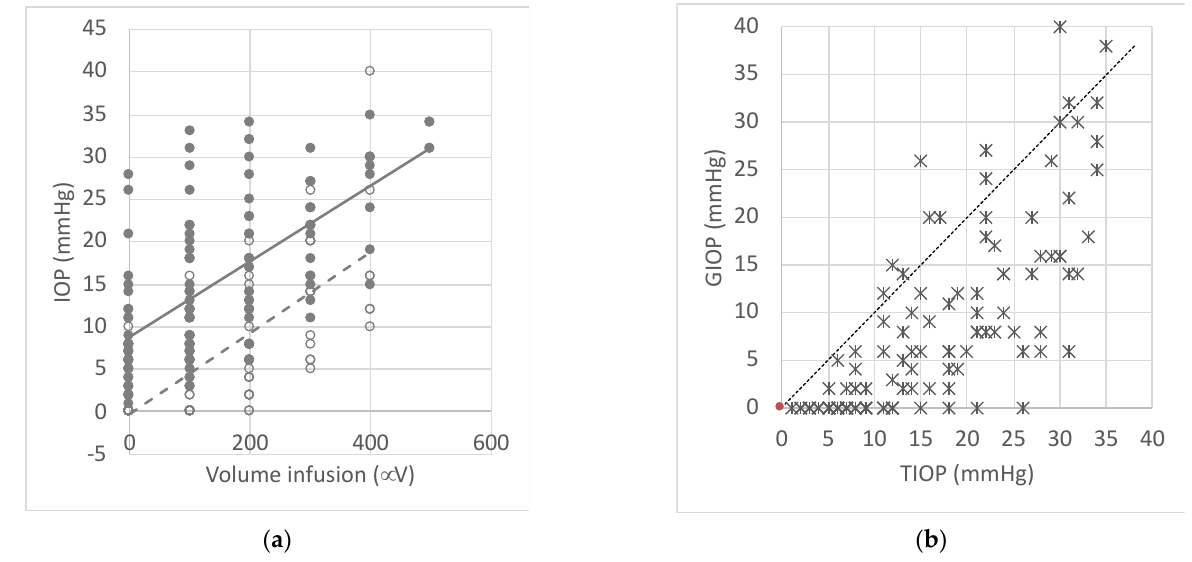
Figure 3. ( a ) Intraocular pressure, IOP, resulting from discrete volume infusions of 0, 100, 200, 300, 400, and 550 μ L. Filled symbols and continuous line are the transducer intraocular pressure, TIOP, data and TIOP trendline, respectively. Empty symbols and dashed line are Goldmann intraocular pressure data, GIOP, and GIOP trendline, respectively. ( b ) GIOP as a function of TIOP measured in the same pig eye. The line represents the first quadrant bisector.